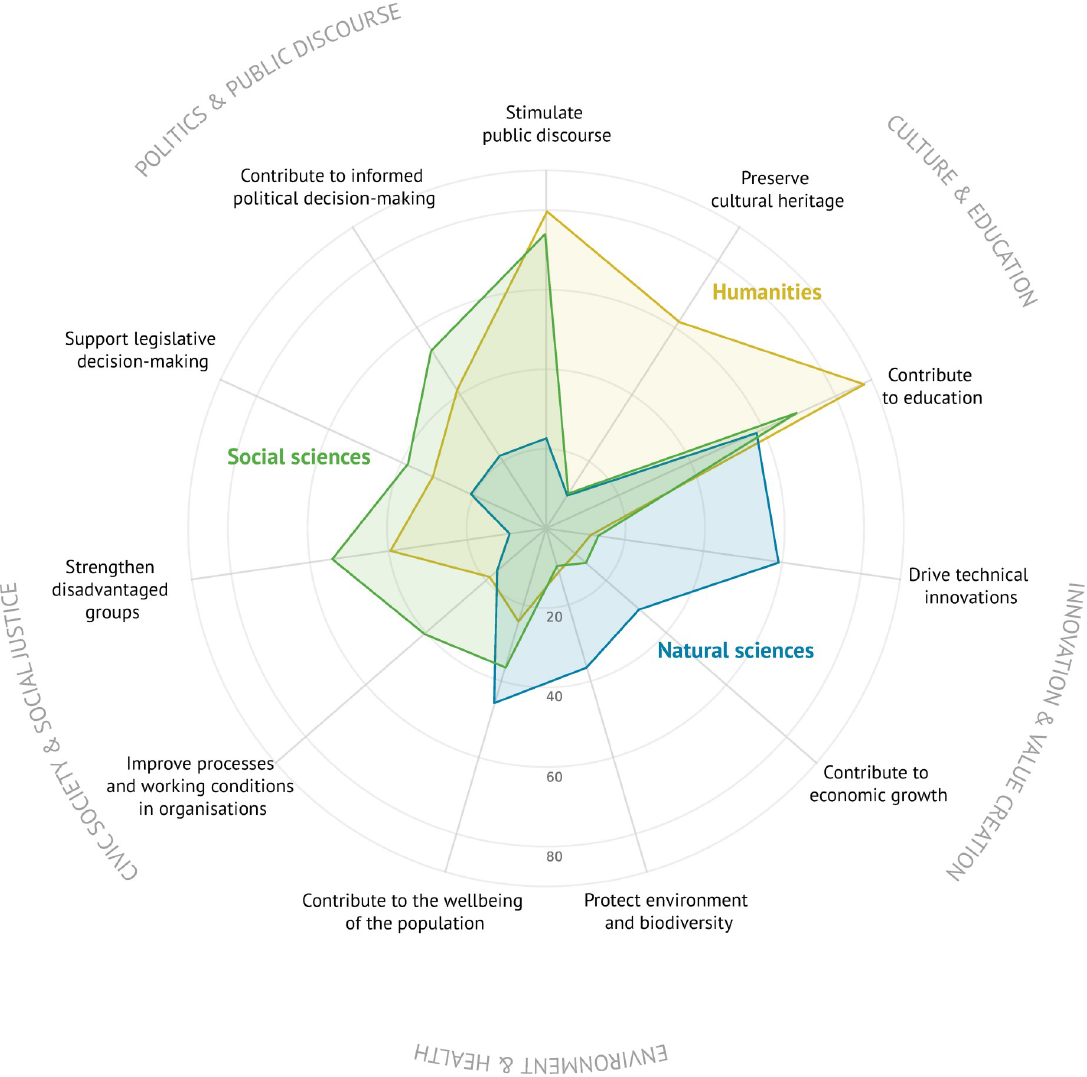
Fig 3. Research goals by disciplinary groups. The radar chart illustrates which goals researchers from our three disciplinary groups pursue when communicating with nonscientific audiences. The numbers are based on the question “What social effects do you most likely want to achieve with your research? With my research, I would like to ... ”. The original question contained two more options (“ ... contribute to national and/or international security.” and “ ... create an entertainment offering.”), but these were chosen by less than 10% of the respondents and are therefore